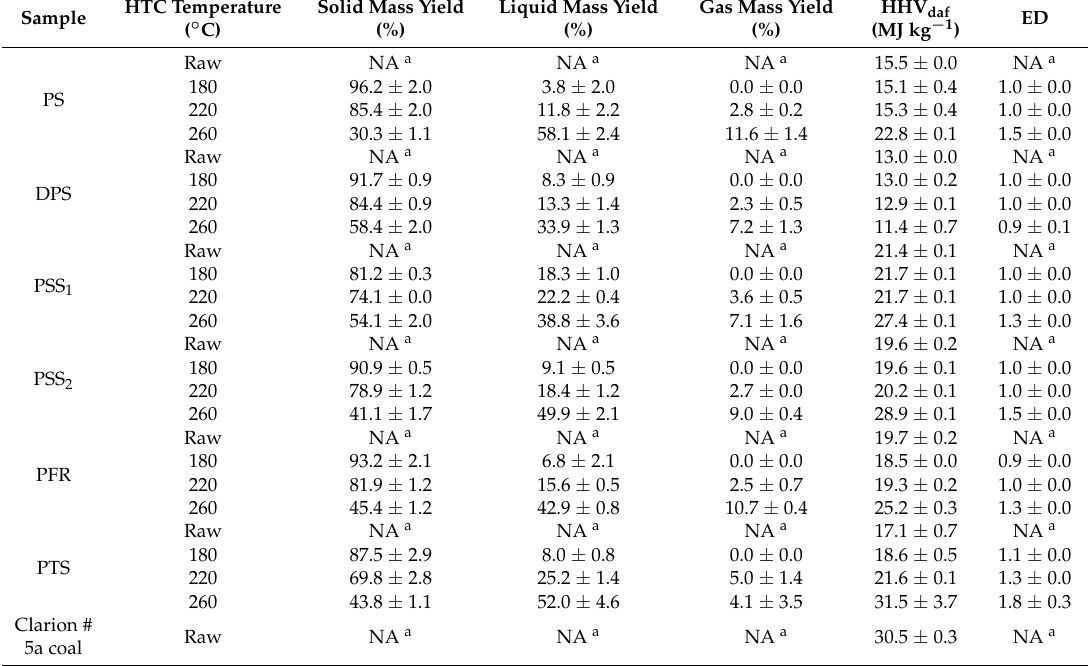
Table 2. Mass yields and energy densification of paper mill sludges (PMS) and their hydrochars ( a Not